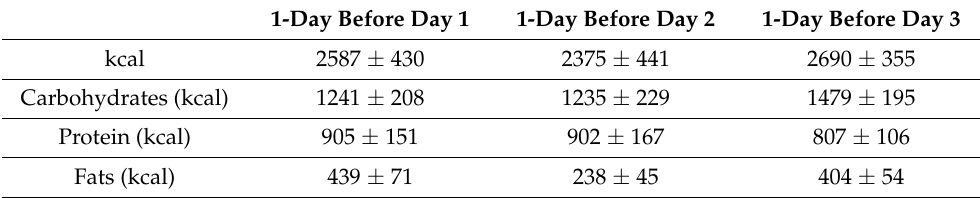
Table 1. Calorie consumption 1 day before